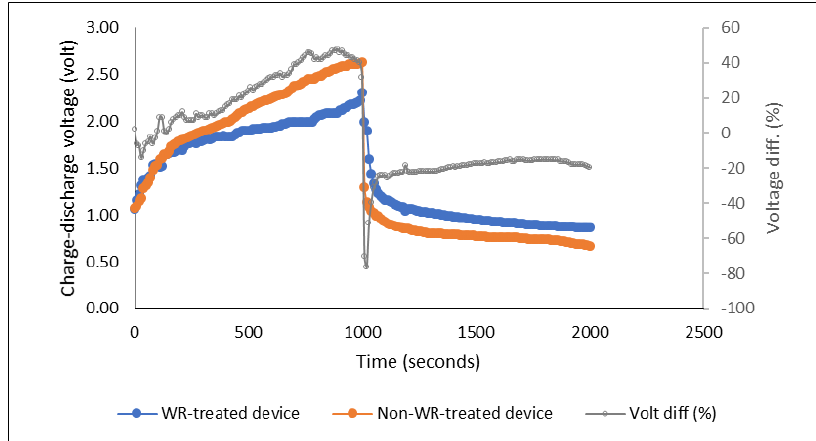
Figure 4. Charge-discharge profile of the water repellent- versus non-water repellent-pre-treated devices (“Volt diff” shows the difference of charge-discharge voltage of the two compared devices recorded along the measured times).